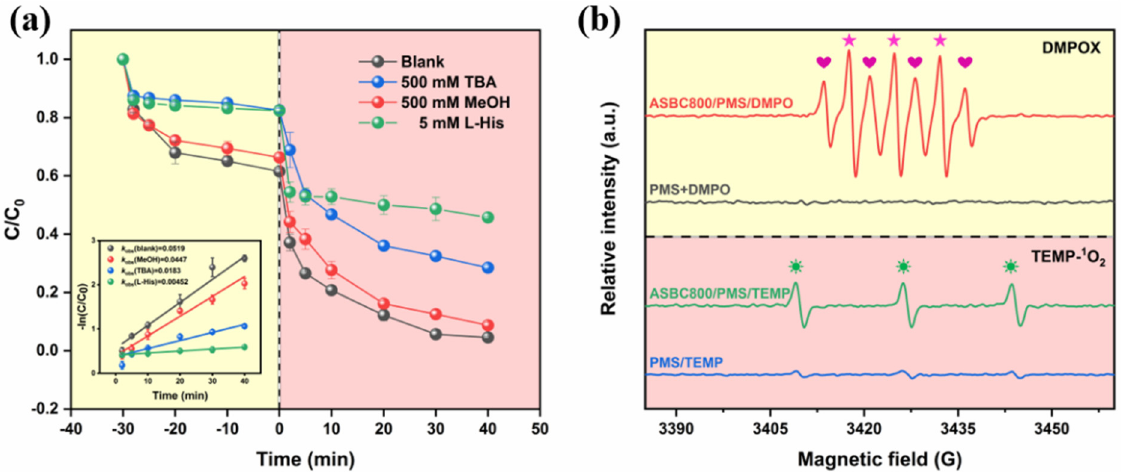
Figure 8. Effects of scavengers on SDZ degradation in PMS/ASBC800 system ( a ) and the result of EPR characterizations ( b ). (5,5-dimethylpyrroline-N-oxide: (DMPO), DMPO-adducts: (DMPOX), 2,2,6,6-tetramethyl-4-piperidinol: (TEMP), TEMP-adducts: (TEMP- 1 O 2 )).